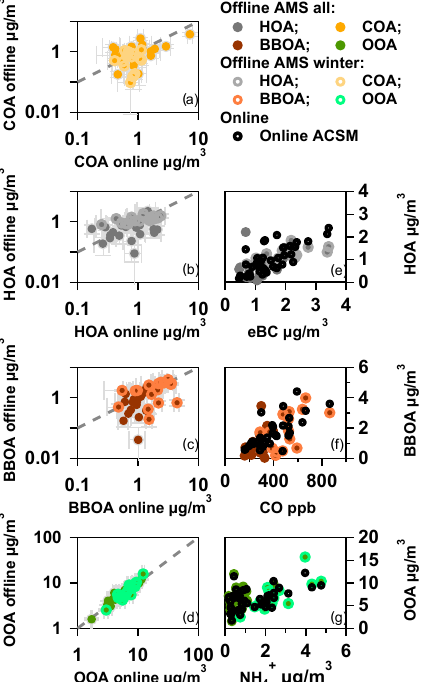
Figure 11. Comparison of factor contributions from separate of- fline (PM 10 AMS, two constrained factors: HOA, COA) and online (PM 1 ACSM) source apportionment using ME-2 (traffic (HOA), cooking (COA), biomass burning (BBOA), and oxygenated organic aerosol; OOA = OOA1 + OOA2). Factor-specific recoveries ( R k ) are applied to the offline contributions. Error bars (in gray) denote the variability between the different ME-2 solutions and for dif- ferent recorded spectra per sample for offline and for online only the first of the two. Panels (a–d) show scatter plots comparing the absolute contribution of the respective source/OA category for offline AMS and online ACSM measurements. The color code dis- tinguishes all factor contributions (bullets, saturated colors) from winter points (open circle, light colors). The gray dashed line indi- cates the 1 : 1 line. Panels (e–g) show the correlation with the re- spective markers: black symbols represent the absolute contribution of the respective source for the online ACSM measurements and the colored symbols represent the absolute contribution of the same source for the offline AMS measurements.